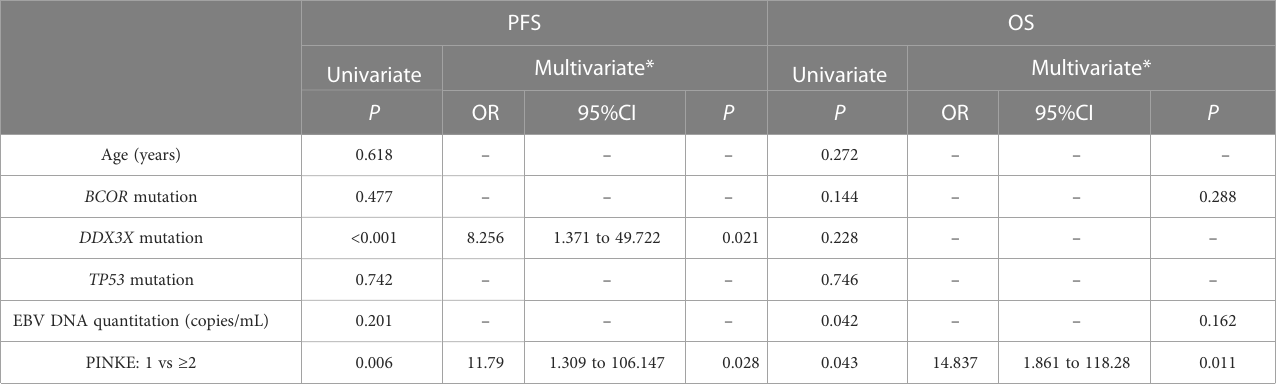
TABLE 2 Analysis of prognostic factors for ENKTL